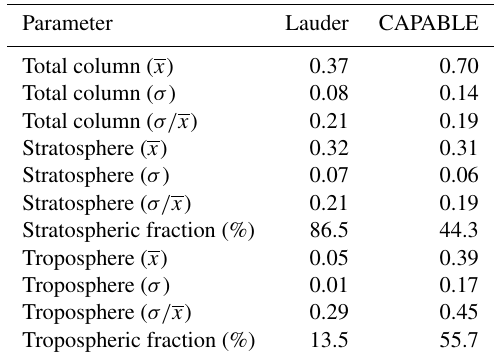
Figure 1. Annual average for OMI NO 2 (L3, v3.0) maps over New Zealand and North America. OMI pixel sizes (nadir and swath edge) are represented by the white boxes within each panel. For compari- son purposes, both plots were put on the same color scale. Table 2. Statistics regarding stratospheric and tropospheric contri- bution and variability of NO 2 (vertical-column density) as observed by OMI. All units are × 10 16 moleccm − 2